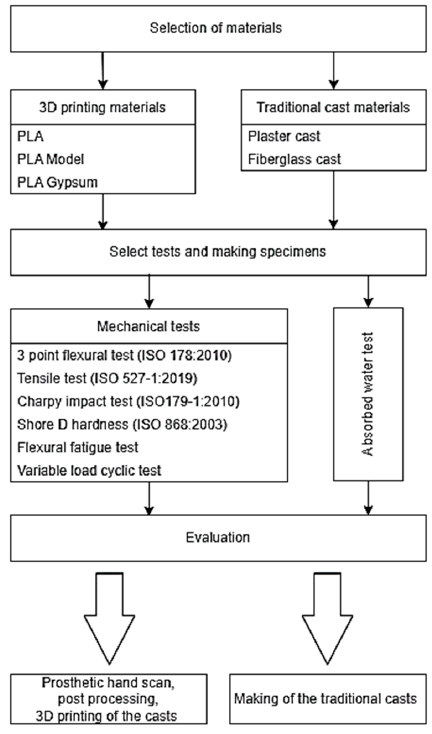
Figure 1. The study protocol.